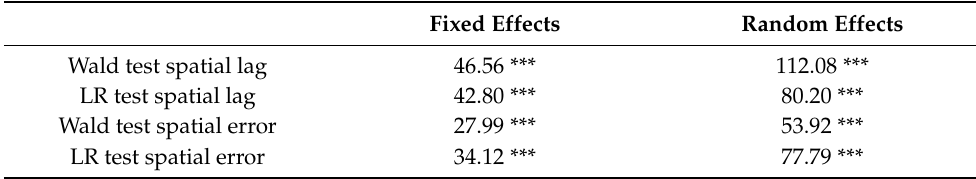
Table 3. The regression results of Likelihood ratio test and Wald test.